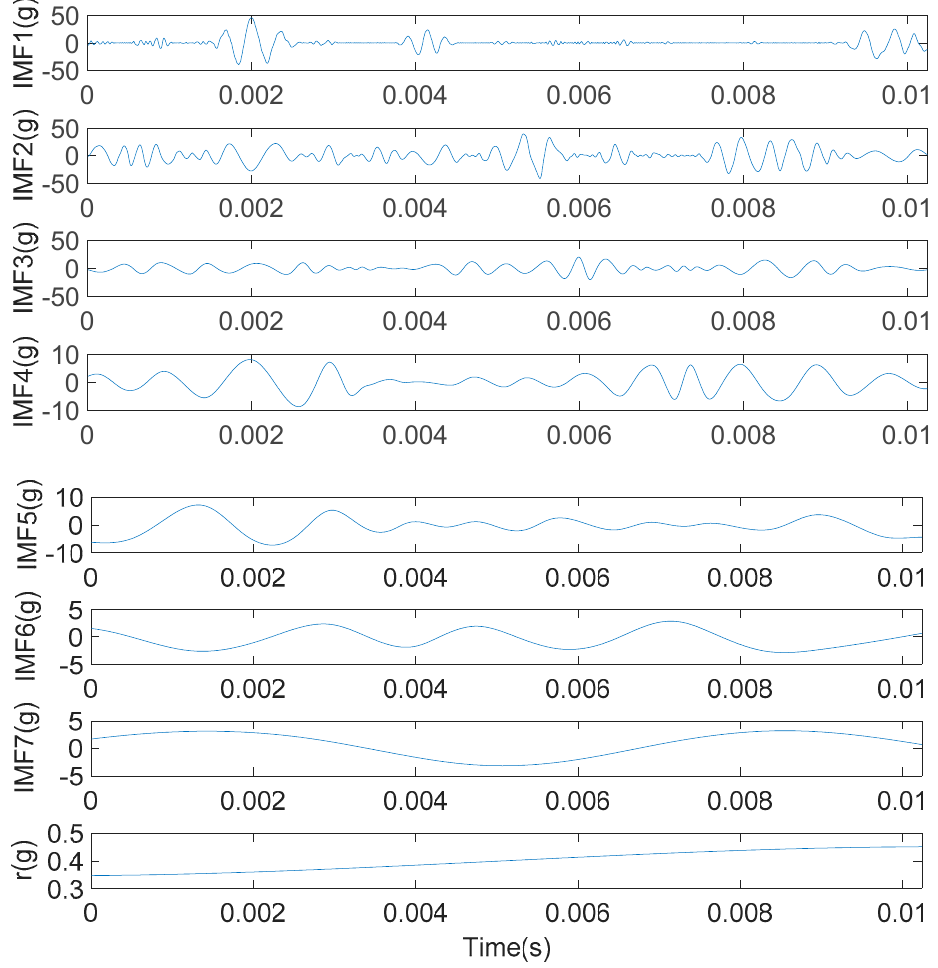
Figure 12. The intrinsic modal function (IMF) component of the engine block vibration signal under a weak knock condition at 5100 rpm.